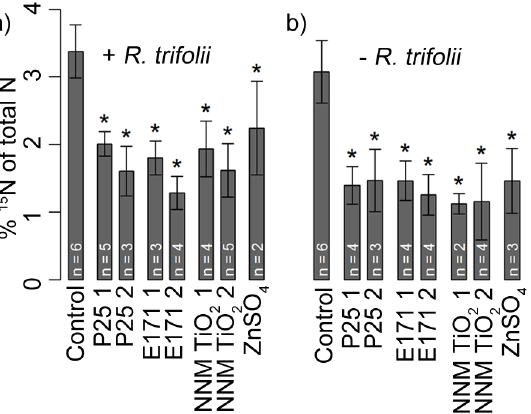
Fig 5. 15 N content (% of total N) of red clover shoots. Results are shown for the control, the different TiO 2 NPs in two concentrations (1 = low, 2 = high) as described in Table 1 and the ZnSO 4 treatment (a) with addition of R . trifolii and (b) without R . trifolii inoculation. Error bars indicate standard deviations, asterisks show significant differences compared to the control (p < 0.05) and number of replications are indicated on